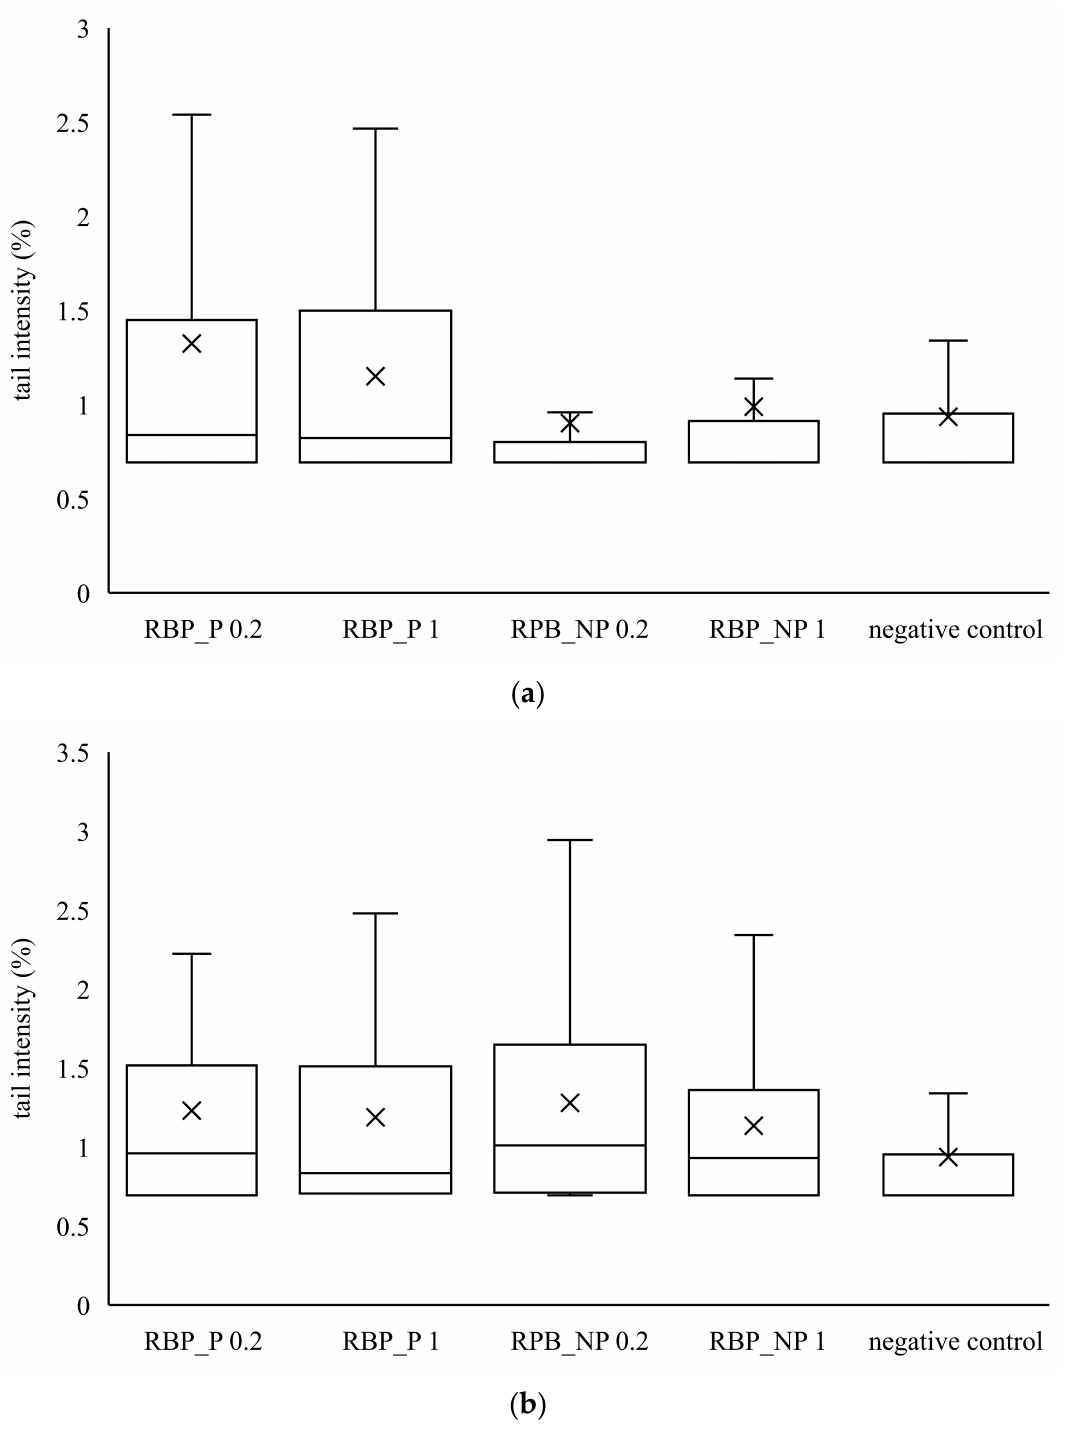
Figure 4. Genotoxic effect of red beetroot peel extract on ( a ) CaCo2 cells and ( b ) HepG2 cells. A box and whisker plot summary of a set of tail intensity data obtained in 100 comets. X represents the mean value of tail intensity, the bottom line is the minimum, the middle line represents the median value of tail intensity, and the area above the median line is the third quartile of the tail intensity data. The upper whisker is the maximum value measured by the comet assay. RBP_P-red beetroot peel extract with polysaccharides; RBP_NP-red beetroot peel extract without polysaccharides, concentrations 0.2 and 1 mg mL − 1 .